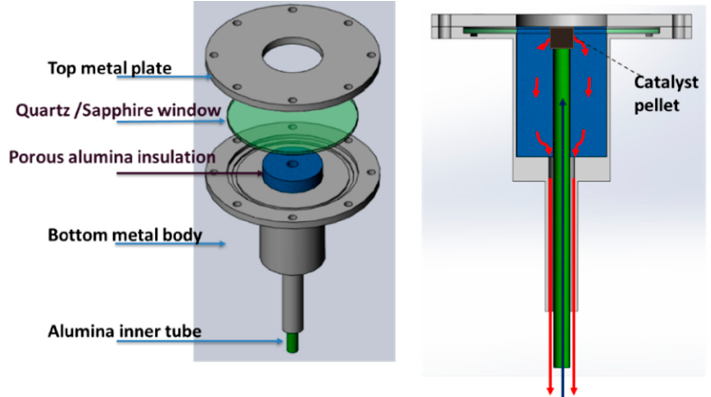
Figure 2. Reactor design. The catalyst pellet is placed at the top of the inner tube near the top of the porous alumina insulation. On the right figure, gas flow (blue arrows) enters from a center tube, flows through the catalyst, and then exits (red arrows) in the annular space between the inlet tube and the outer (exit) tube.